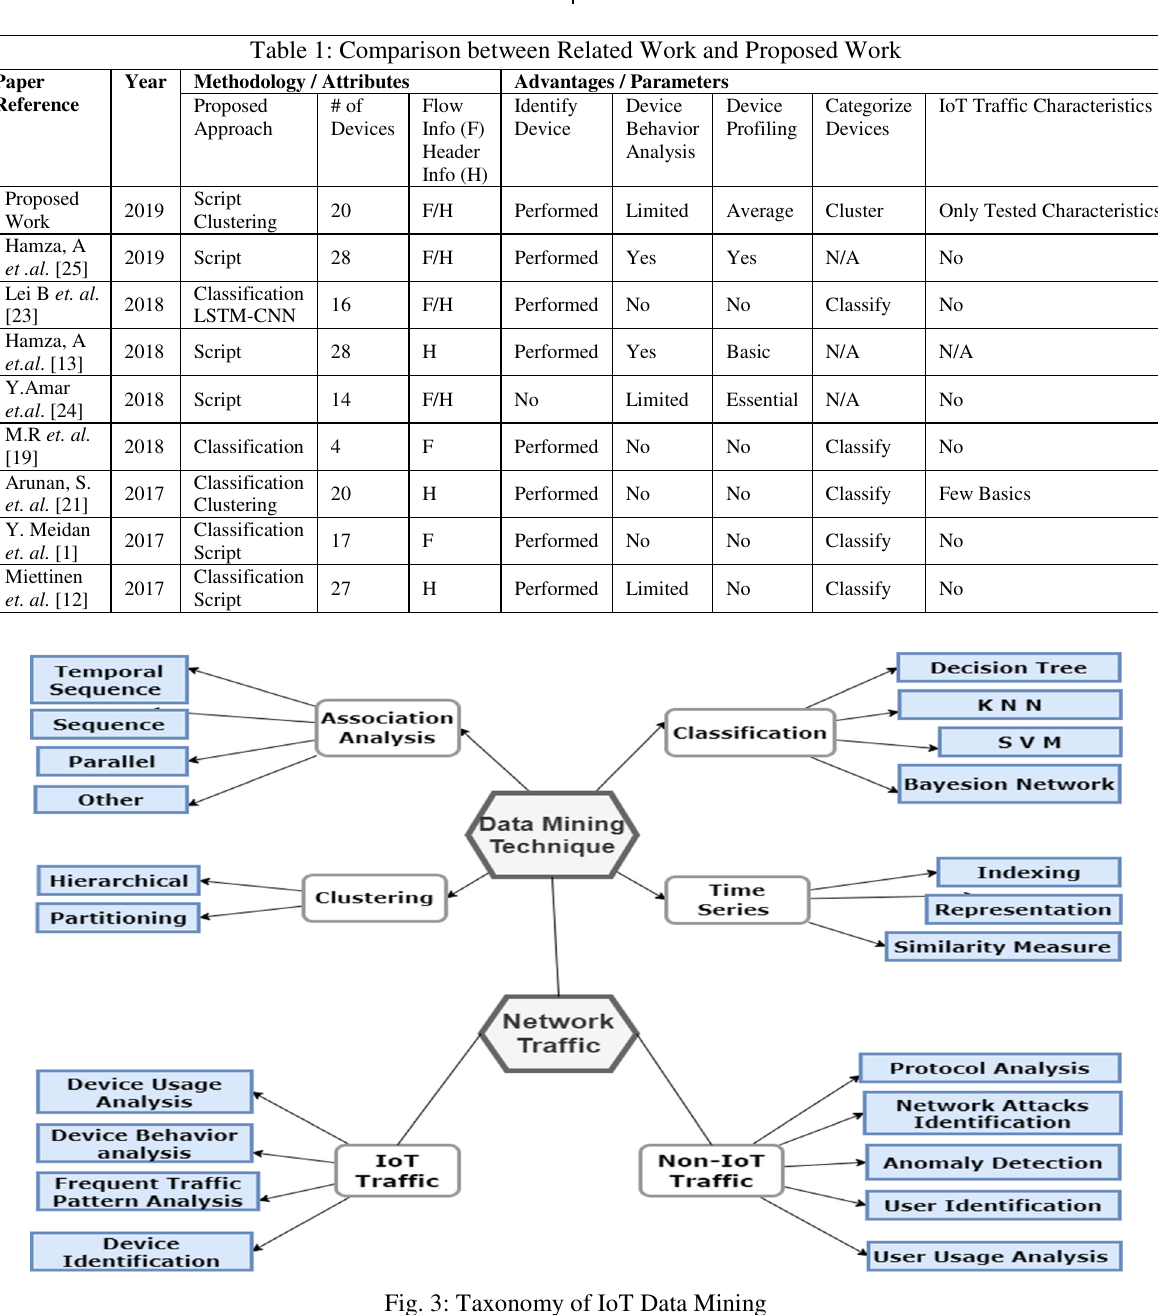
Fig. 3: Taxonomy of IoT Data Mining